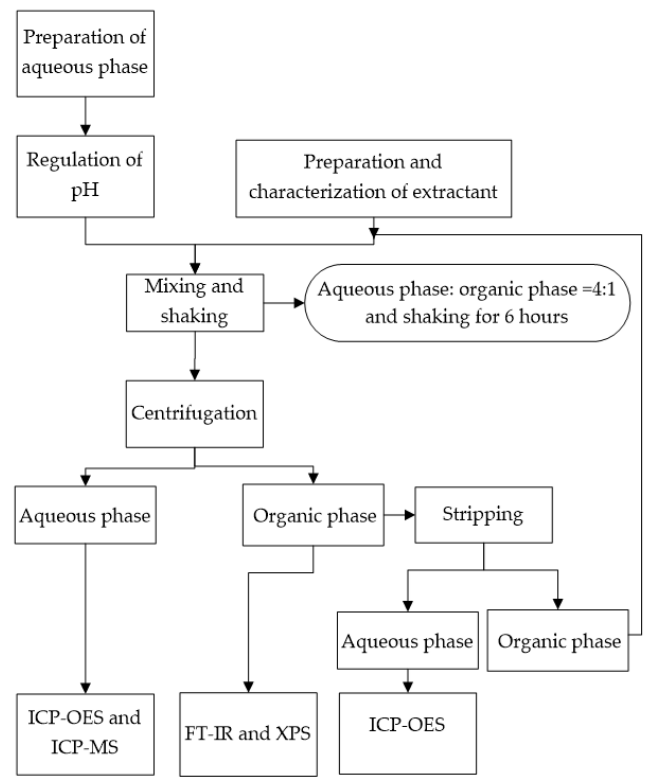
Figure 1. Experimental